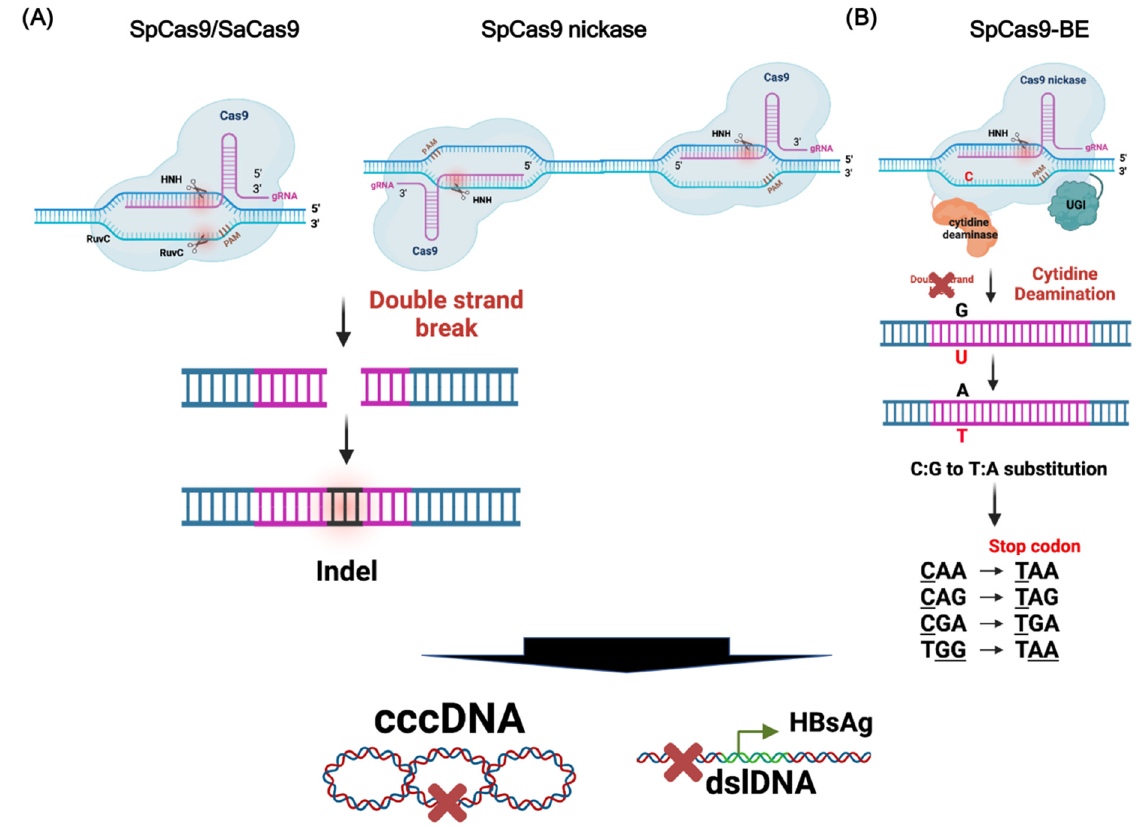
Figure 3. The mechanisms of CRISPR-Cas9 mediated gene therapy against HBV. The cccDNA and integrated HBV DNA are inactivated by ( A ) cleavage with wild-type CRISPR/Cas9 or ( B ) base editing with Cas9-base editor.